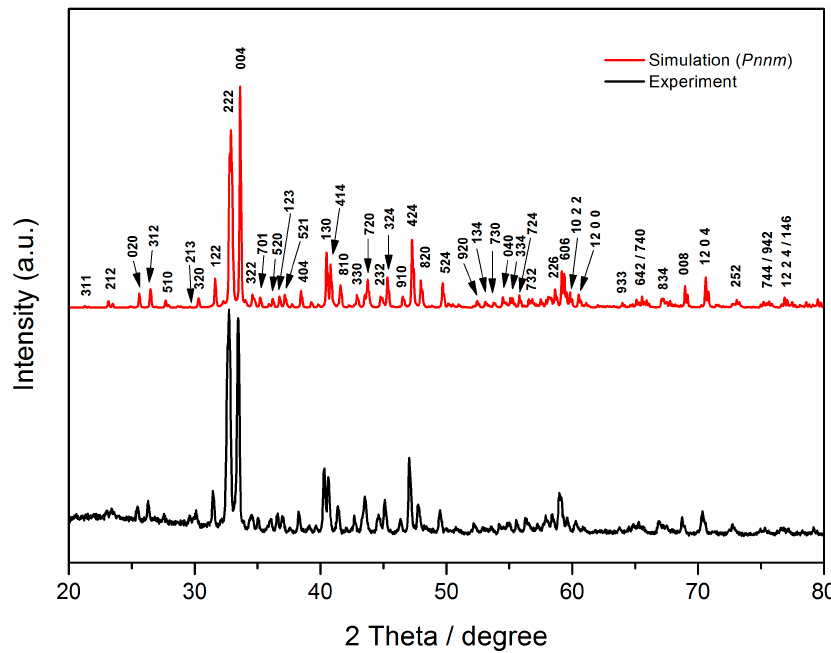
Figure 1. Experimental and simulated powder X-ray diffraction patterns of Ca 7 MgSi 4 O 16 -Bre (bredigite). Numbers represent the hkl indexes. ite). Numbers represent the hkl